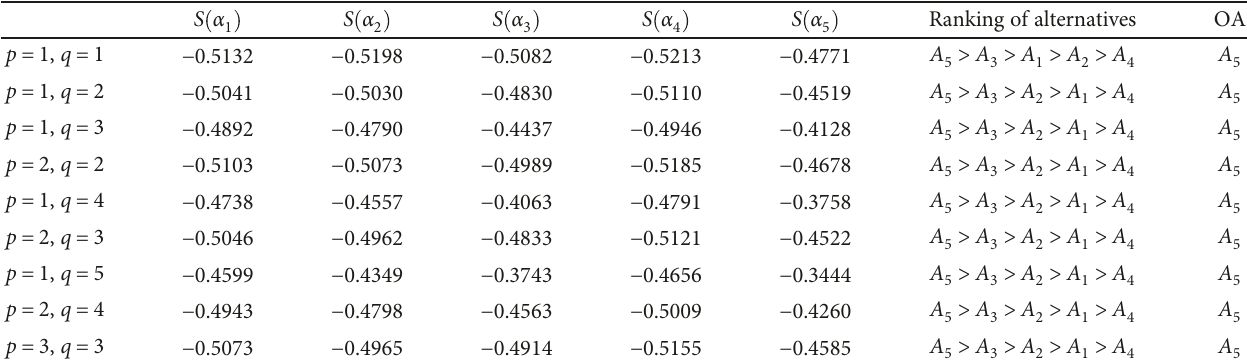
Table 6: Results of di ff erent p and q without considering